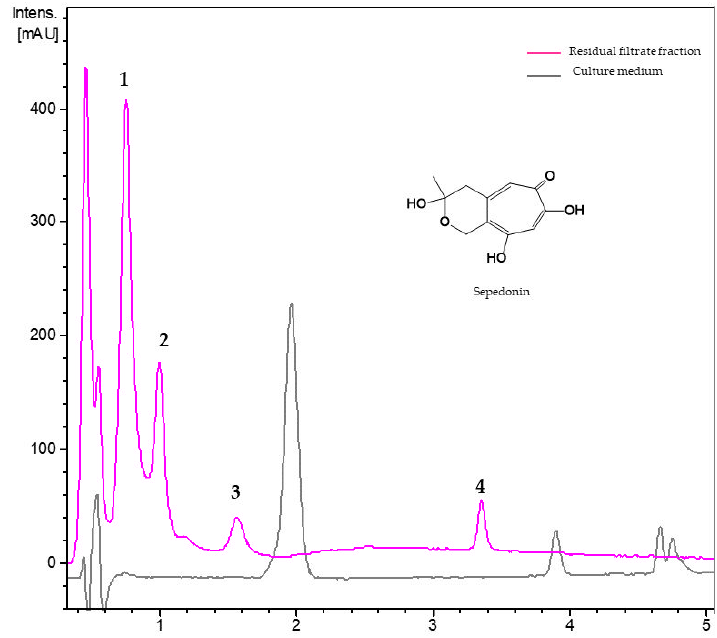
Figure 6. UV 210 nm chromatogram of residual filtrate fraction from Trichoderma virens Th27-08 and the unfermented culture medium. 1 : Not identified (C 11 H 10 O 4 ), 2 : sepedonin, 3 : not identified (C 11 H 10 O 4 ), 4 : not identified (C 16 H 20 O 4 ). Table 6. Dereplicated metabolites from residual fractions of Trichoderma virens Th27-08.